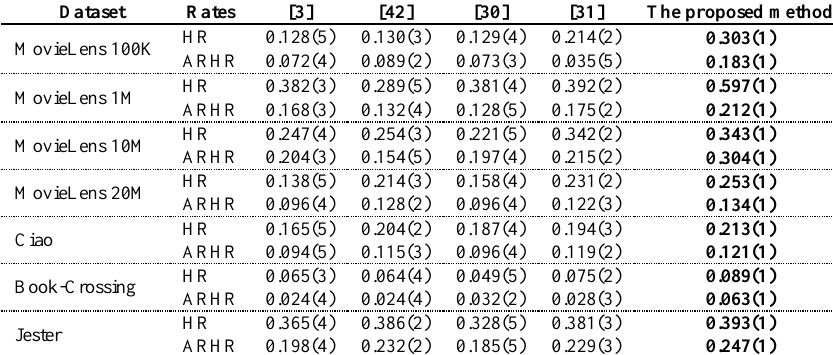
Table 6. Performance comparison of methods.